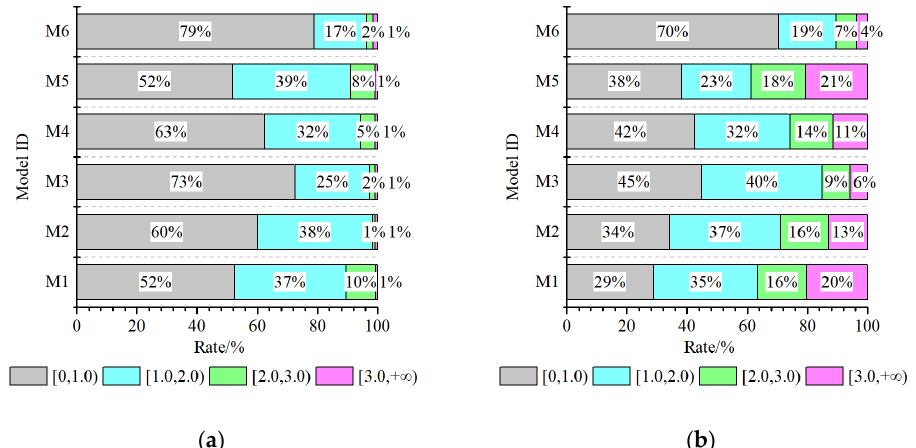
Figure 20. The average column hinge rate along the slope direction: ( a ) a PG, x = 0.4 g; ( b ) a PG, x = 0.62 g.